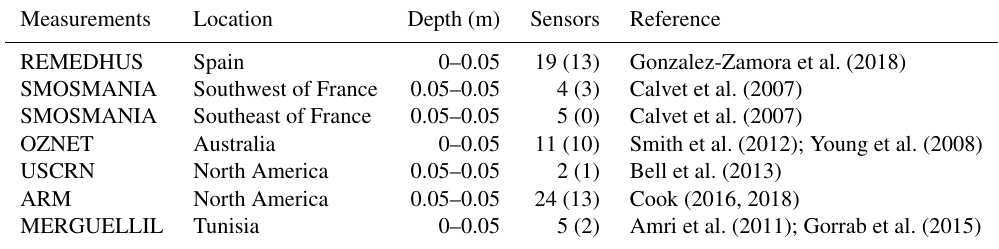
Table 1. In situ measurements that were used in this study. The depths are given as two numbers, where the first one is the upper depth of the sensor, and the second one is the lower depth of the sensor. Both numbers are equal when the sensor is placed horizontally. The fourth column shows the number of sensors that provide SM measurements in 2019. These measurements were used to convert the relative indices from CoperSSM and CoperSWI into SM estimates with volumetric units (m 3 m − 3 ; Sect. 3.2). The number in parenthesis corresponds to the number of in situ locations where the evaluations of the remotely sensed data were significant ( P value below 5%; Sect.